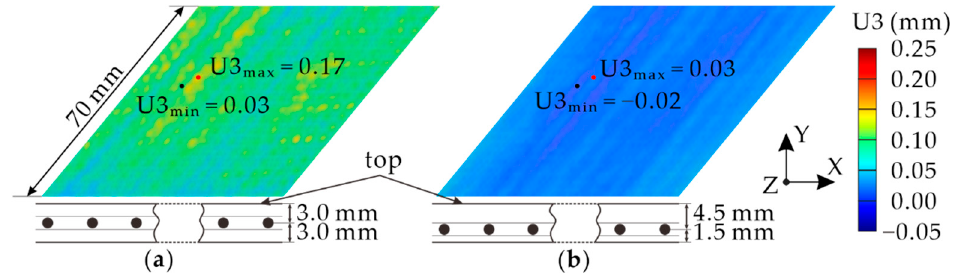
Figure A1. Configuration of the skin top surface with l : ( a ) l = 3 mm; ( b ) l = 4.5 mm.